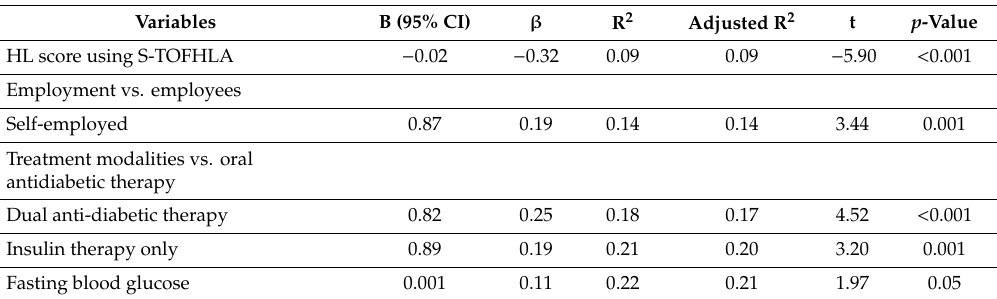
Table 4. Predictive factors for HbA1c